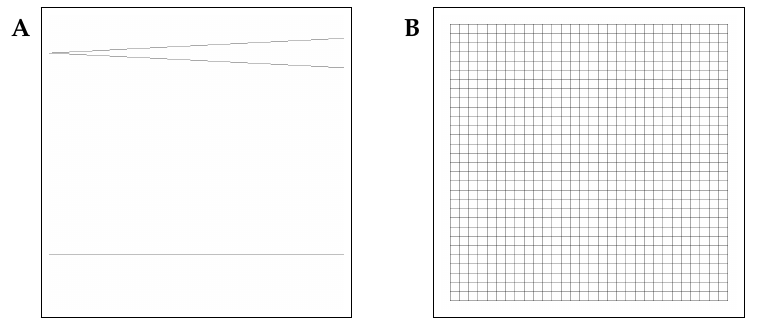
Figure 6. Two additional sample images. ( A ) Modified version of Figure 4A with the top two lines at an angle of 0.1 radians from each other. ( B ) A simple grid with a uniform line spacing of 32 pixels.